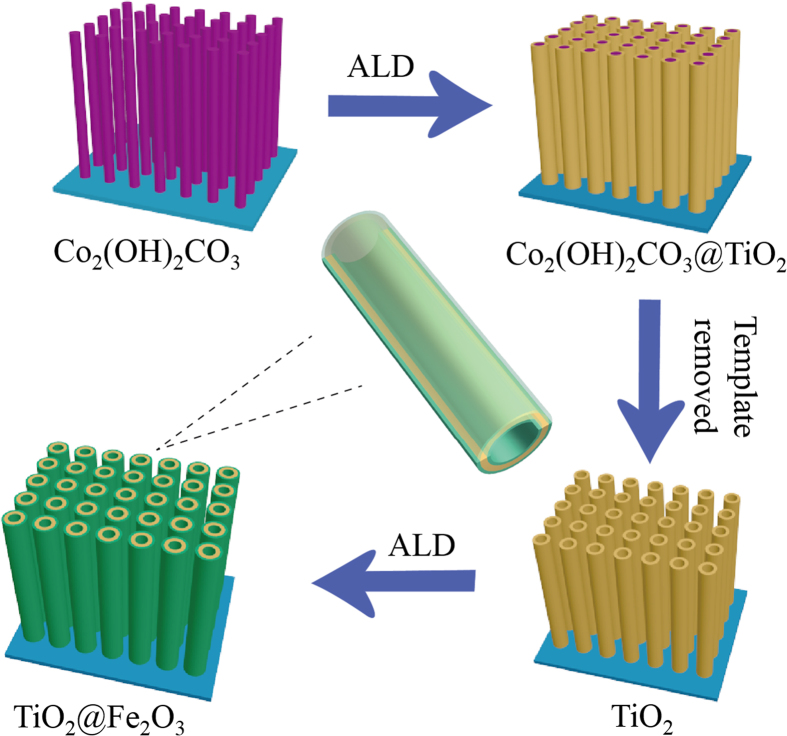
Schematic illustration of the formation process for the TiO2@Fe2O3 core-shell nanotube arrays with double-side coating.